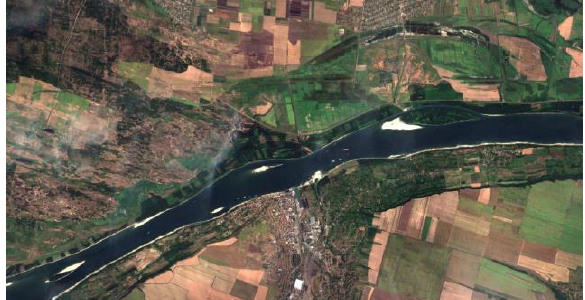
Figure 9. Rast Harbour – 08.08.2015 - Sentinel-2A